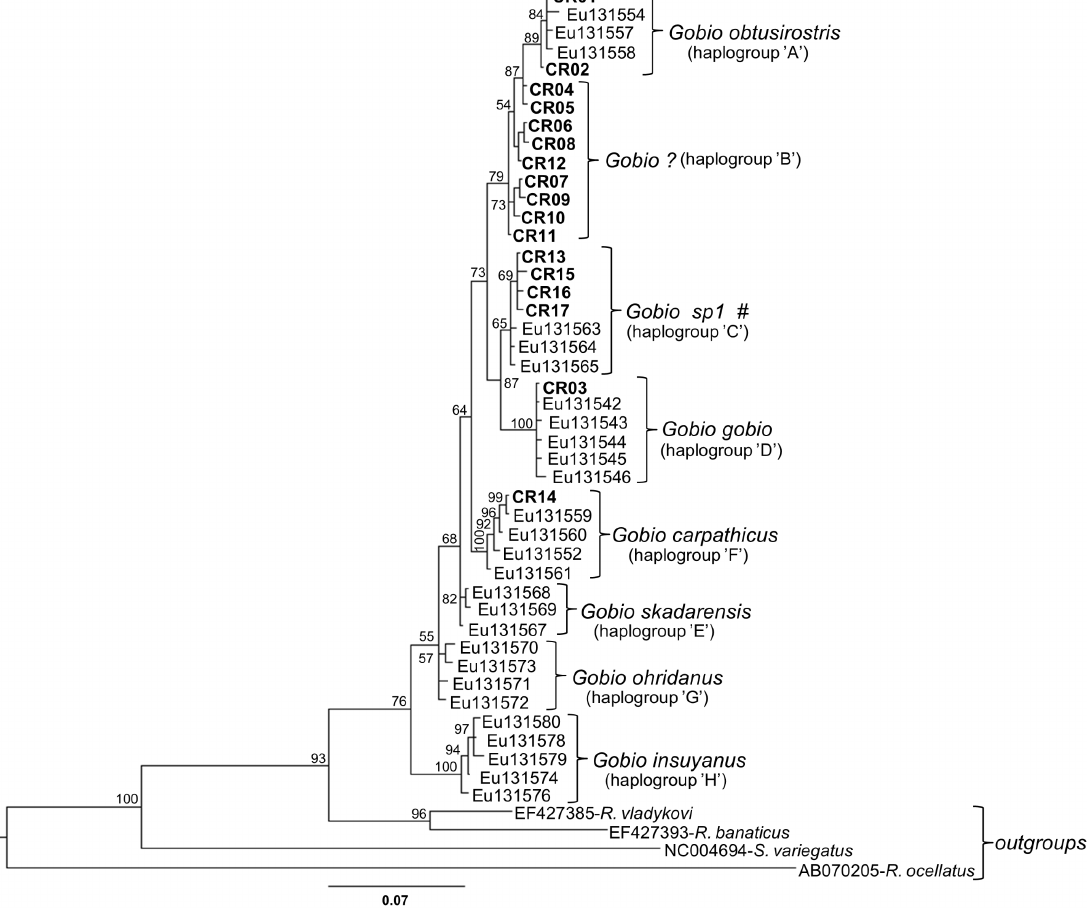
Figure 3. Bayesian consensus tree derived from the analysis of the mtCR sequence data. Haplotypes revealed in this study are marked with their CR codes (see Table 3). Bayesian posterior probabilities are assigned on nodes. For GenBank accession numbers see the text and Table 2. # : taxon name described in Mendel et al. (2008). doi:10.1371/journal.pone.0097278.g003 where 2n xy equals the number of shared character states and n is the total number of binary characters. Population genetic structure was characterised by hierarchical AMOVA [49] with 9,999 randomisations. Isolation by distance was estimated by a Mantel